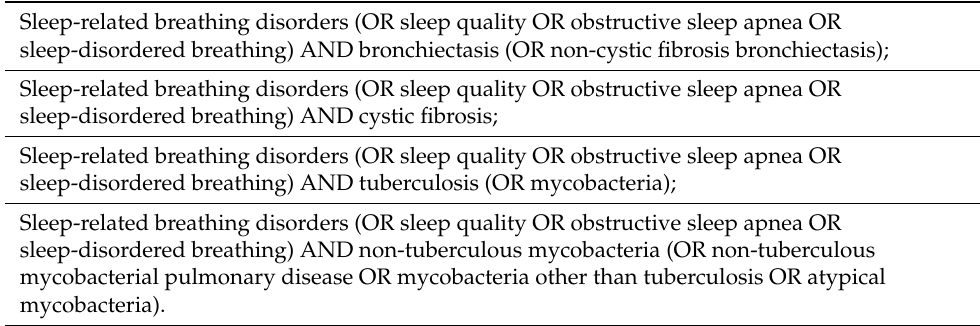
Table 1. Keywords used to perform the